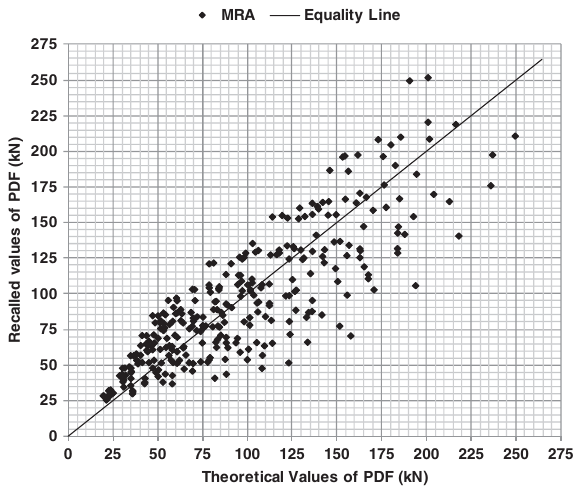
Fig. 11. Recalled P DF values by multiple nonlinear regres- sion vs. theoretical data (set1)